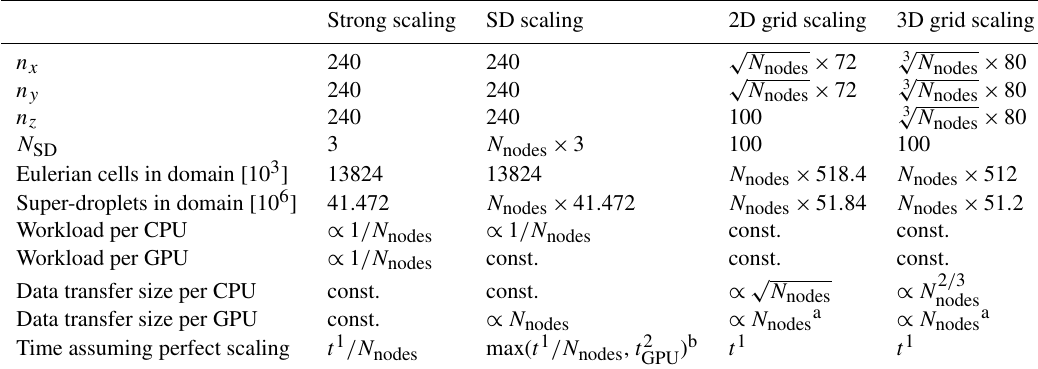
Table 3. Details of multi-node scaling tests. n x , n y and n z is the total number of Eulerian grid cells in the respective direction. N SD is the initial number of super-droplets per Eulerian grid cell. N nodes is the number of nodes used for the simulation. Number of Eulerian grid cells in the domain is equal to n x × n y × n z . Number of super-droplets in the domain is equal to n x × n y × n z × N SD . Workload per CPU is estimated assuming that it is proportional to the number of grid cells per CPU only. Workload per GPU is estimated assuming that it is proportional to the number of super-droplets per GPU only. MPI transfers, data transfers between host and device memories, and GPU handling of information about Eulerian cells are not included in these workload estimates. Data transfer sizes are for copies between different MPI processes but do not include copies between host and device memories of the same process. Data transfer sizes are estimated assuming that time step length and air flow velocities do not change with grid size. t 1 is the wall time on a single node. t 2 and CPU + GPU calculations in a simulation on two